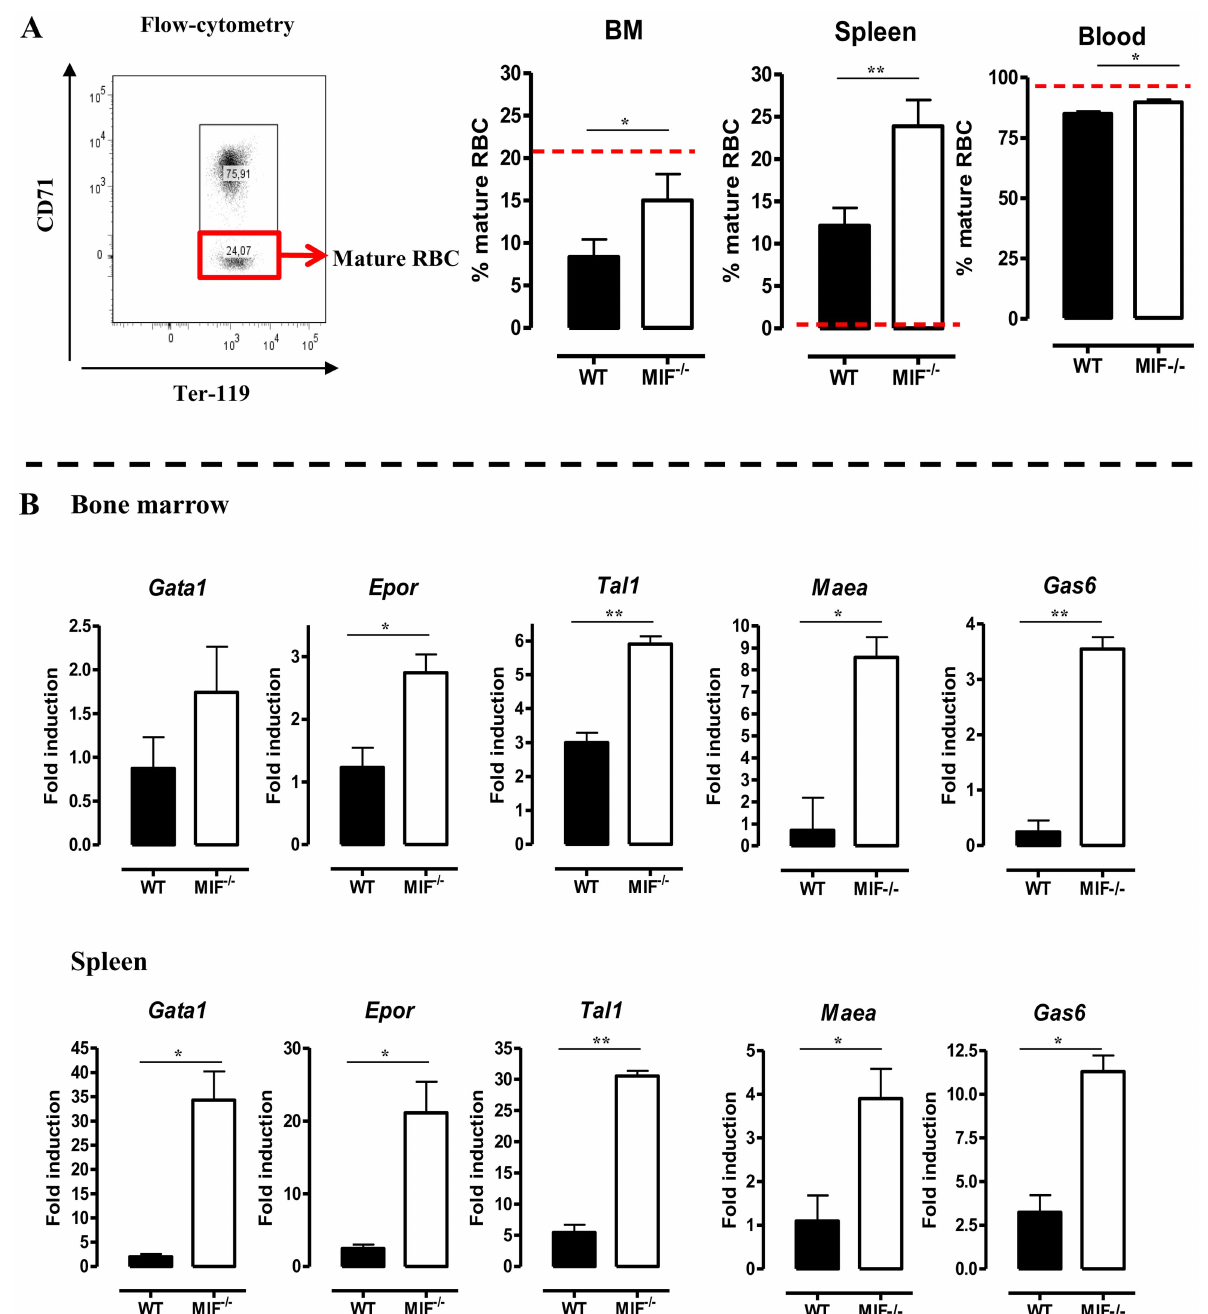
Figure 7. MIF deficiency correlates with restored/enhanced erythropoiesis during T.brucei infection. (A) Representative profile for the gating of mature (Ter-119 + CD71 2 ) and immature (Ter-119 + CD71 + ) RBCs in bone marrow of non-infected C57Bl/6 mice (left panel). The percentage of mature RBCs within the total Ter-119 + population in bone marrow, spleen and blood at day 18 p.i. (right panels). Dashed line represents percentage of mature RBCs in non-infected mice, which was similar in WT and Mif 2 / 2 mice. Results are representative of 3 independent experiments and shown as mean of 3 individual mice 6 SEM. (B) Expression levels of genes involved in erythropoiesis in total bone marrow (upper panels) and spleen (lower panels) from Mif 2 / 2 (white bars) and WT (black bars) mice at day 18 p.i. Gene-expression levels are normalised using s12 and expressed relatively to expression levels of non-infected mice. Results are representative of 2 independent experiments and presented as mean of 3 individual mice 6 SEM (*: p-values # 0.05, **: p-values # 0.01).